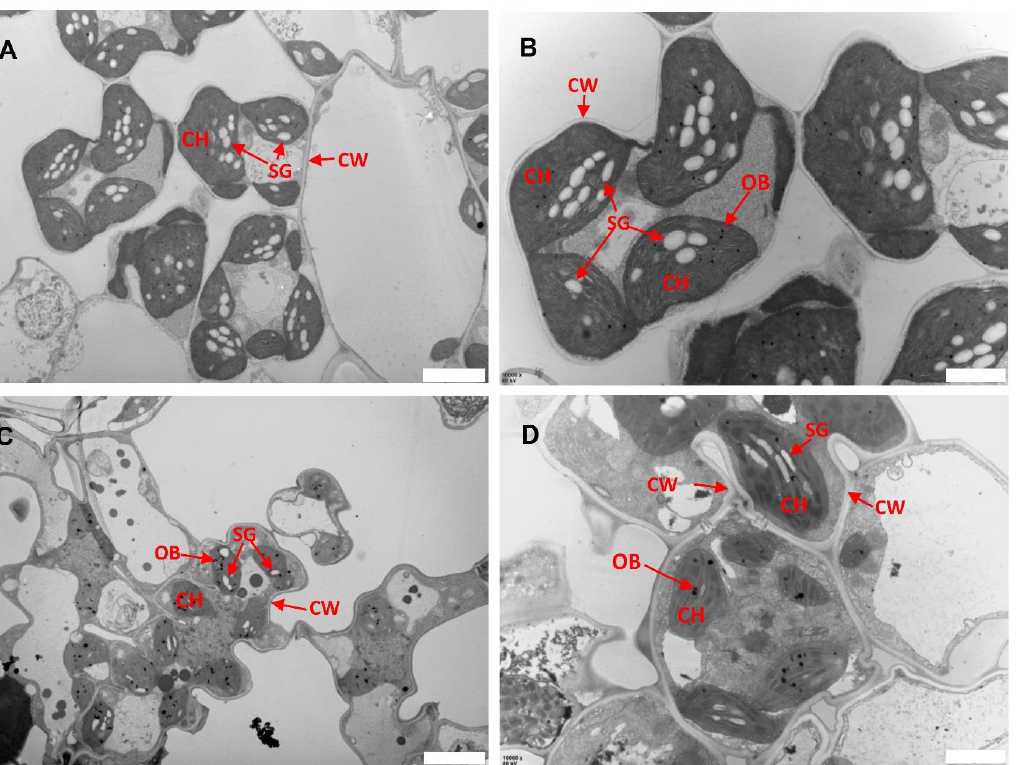
Figure 4. Transmission electron micrographs of leaf sub-cellular structure of WT and llm9428. ( A , B ) Subcellular structure of leaf chloroplast of WT, and llm9428 ( C , D ) at flowering stage under a trans- mission electron microscope. Where CW: cell wall, CH: chloroplast; SG: starch granules and OB: osmiophilic body. Scale bar: 2 µ m in ( A , C ) and 5 µ m in ( B , D